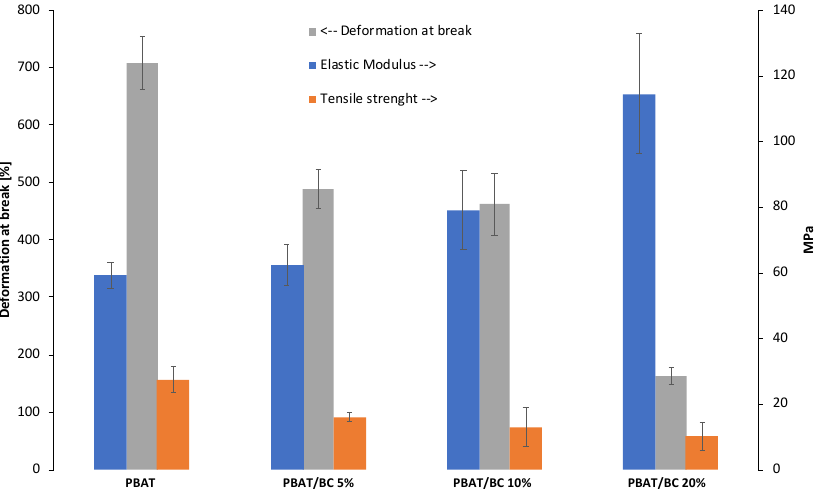
Figure 7. Histogram of the elastic modulus, tensile strength, and deformation at break of PBAT-based casted samples.